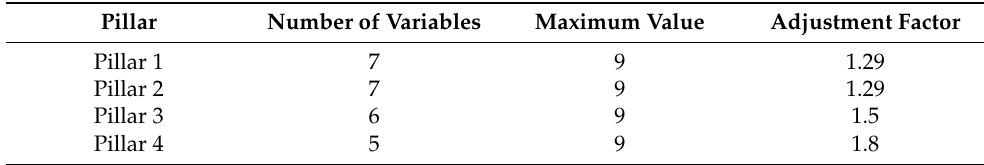
Table 1. Pillars’ Adjustment factors